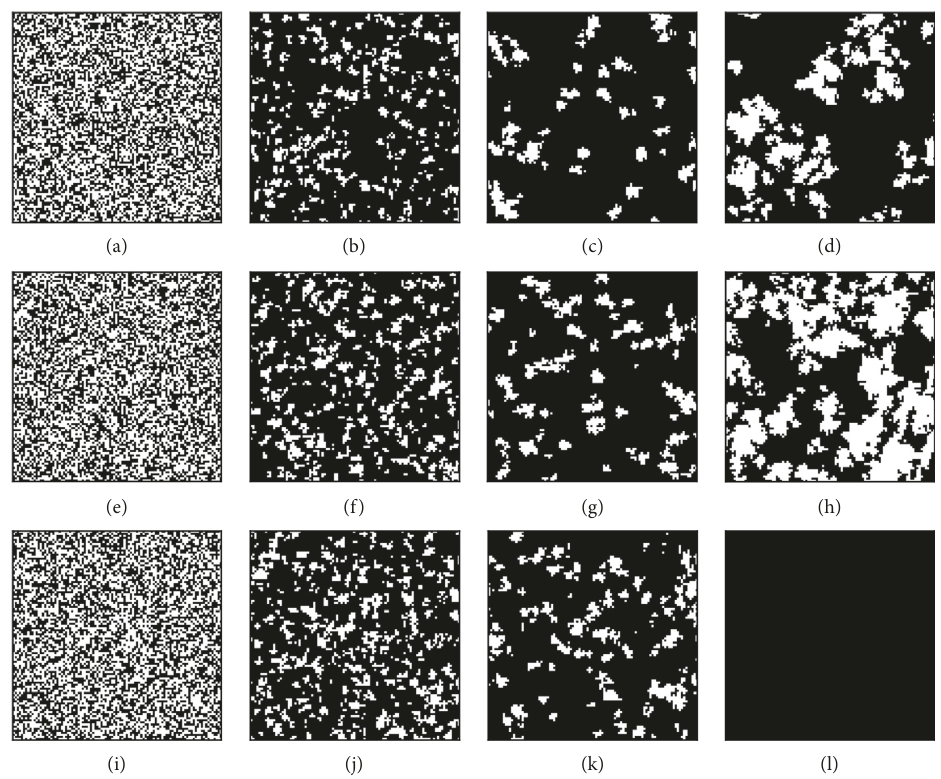
Figure 5: Characteristic snapshots of C and D players on a 100 × 100 square lattice evolve from a random initial state. Here, C ( D ) is denoted as white (black). (a)–(d) show the results with the setting p � 0 . 6 for t � 1, t � 10, t � 50, and t � 100, respectively. (e)–(h) show the result with the setting p � 0 . 8 for t � 1, t � 10, t � 100, and t � 10 , 000, respectively. (i)–(l) show the result with the setting p � 0 . 8 for t � 1, t � 10, t � 100, and t � 10 , 000,